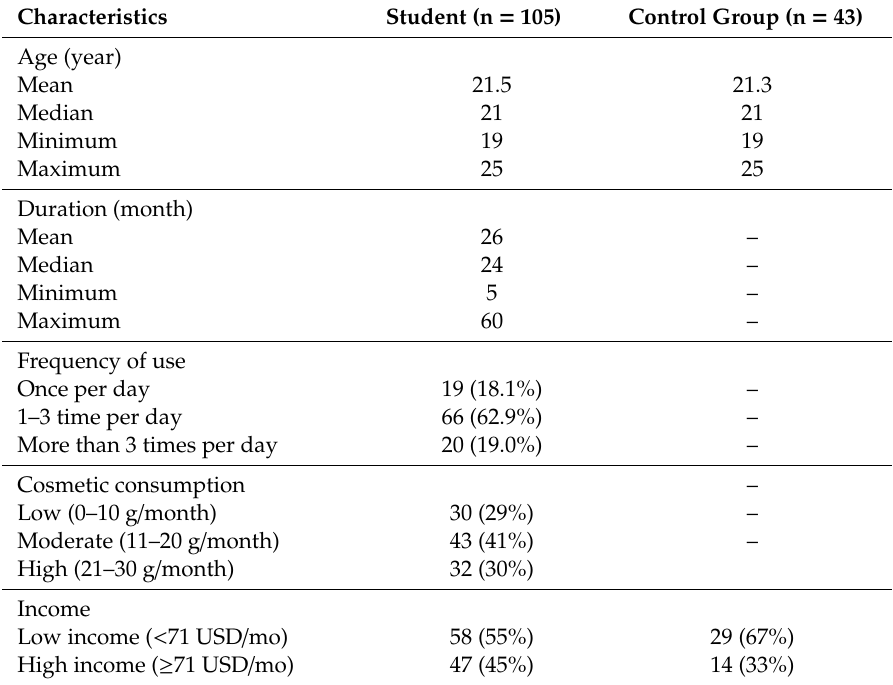
Table 1. Demographic characteristic of the